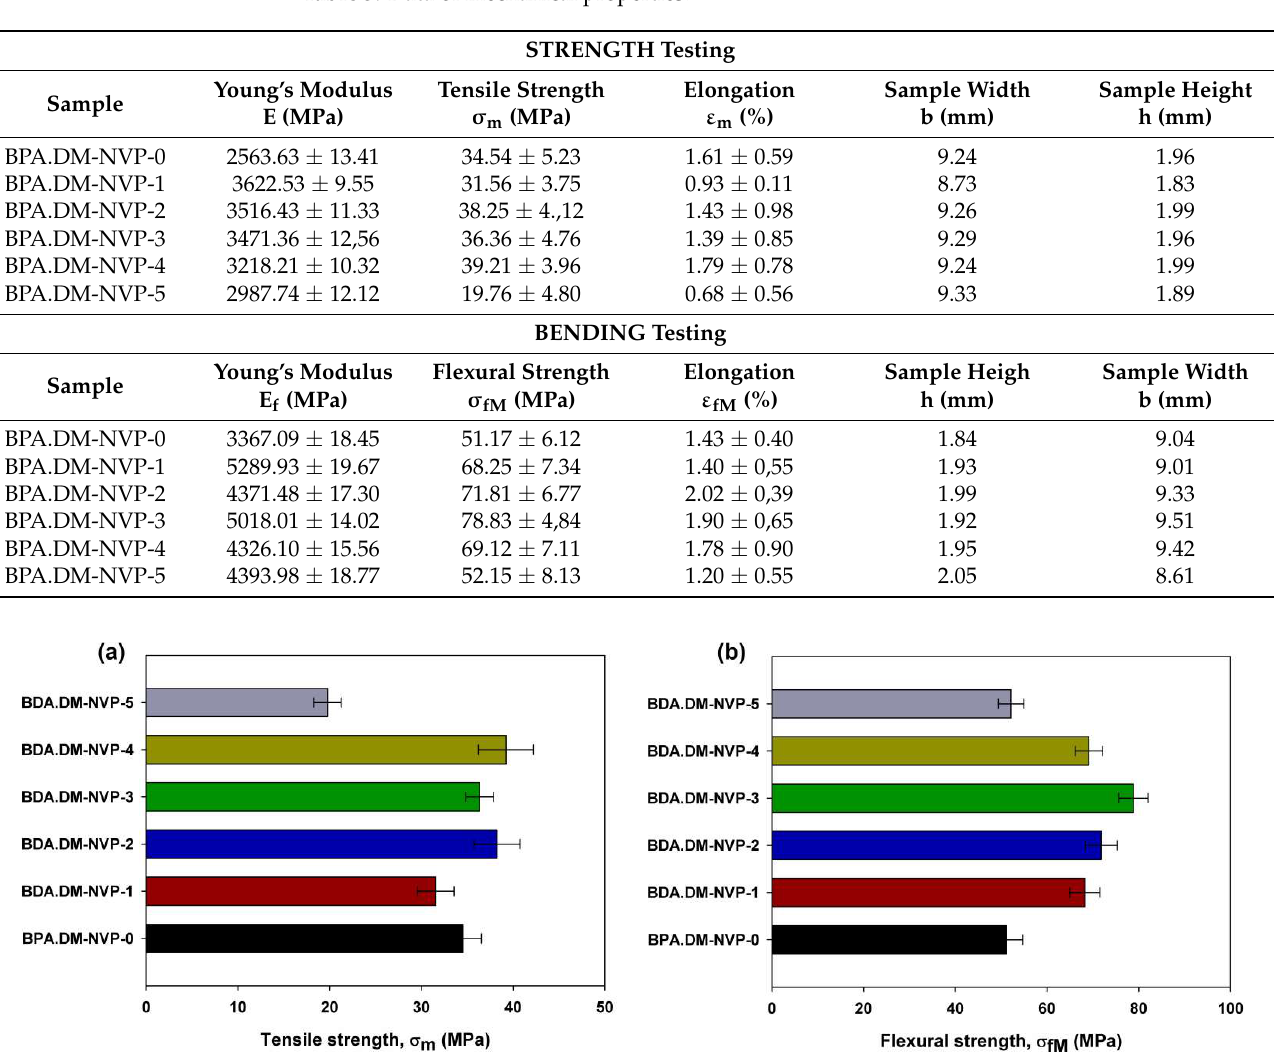
Table 3. Data of mechanical properties.